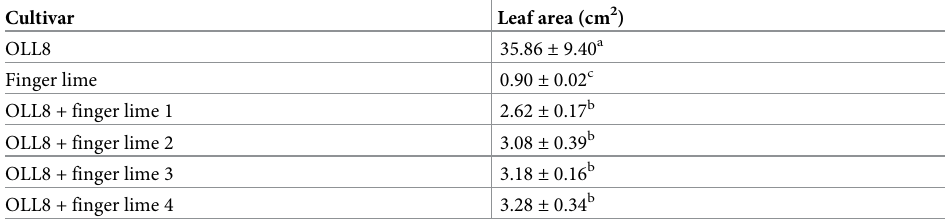
Table 1. Leaf area measurements of the allotetraploid somatic hybrids between OLL8 sweet orange and the finger lime and the diploid parents.